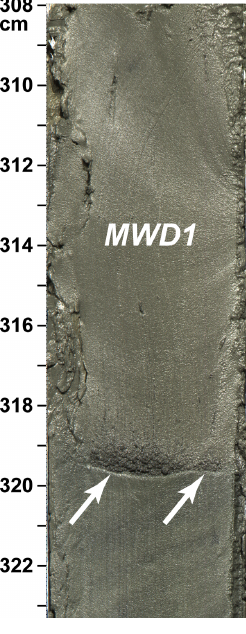
Fig. 5. Photography of the core Co1262, from ca. 308 to 323cm depth, where the AD472/512 tephra as thin, greyish band (arrow) underlies mass waste deposit MWD1 with a sandy